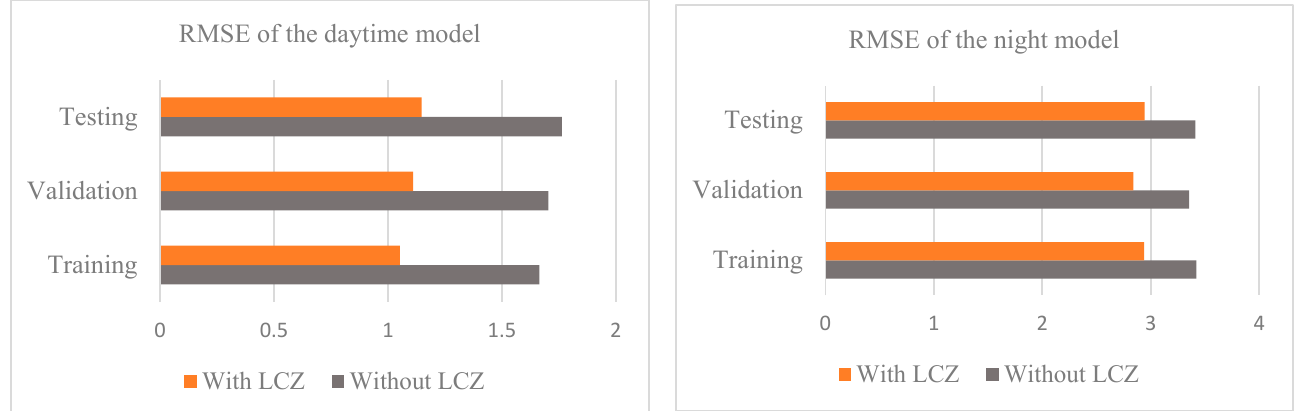
Figure 11. Daytime model performance results.